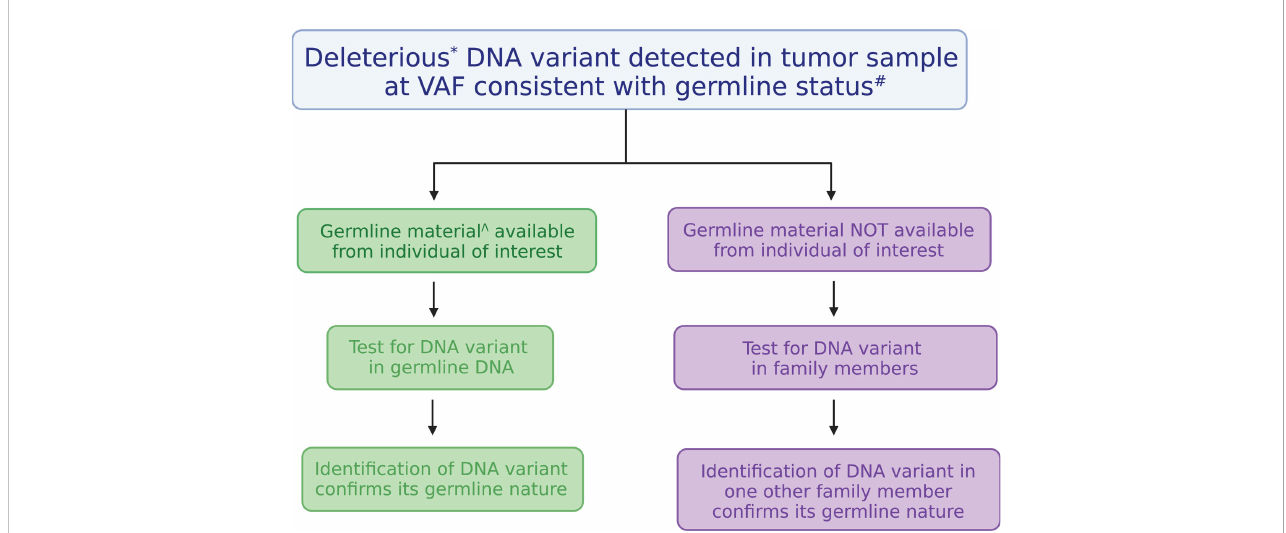
FIGURE 2 Algorithm for testing the germline nature of a DNA variant identi fi ed in a tumor. Testing the germline nature of a DNA variant begins with recognizing a deleterious DNA variant found in a gene known to confer cancer risk at a variant allele frequency (VAF) consistent with a germline allele. Testing can be performed using another DNA sample derived from a tissue considered equivalent to the germline (on left, in green) or through familial segregation (on right, in purple). Figure was generated with BioRender. *Deleterious variants are those classi fi ed as pathogenic or likely pathogenic. # VAFs from 30-60% are generally considered to be consistent with germline status, but they can be as high as 100% depending on chromosome gains or losses. ^ DNA derived from cultured skin fi broblasts, hair bulbs, or bone marrow-derived mesenchymal stromal cells are considered equivalent to germline samples.